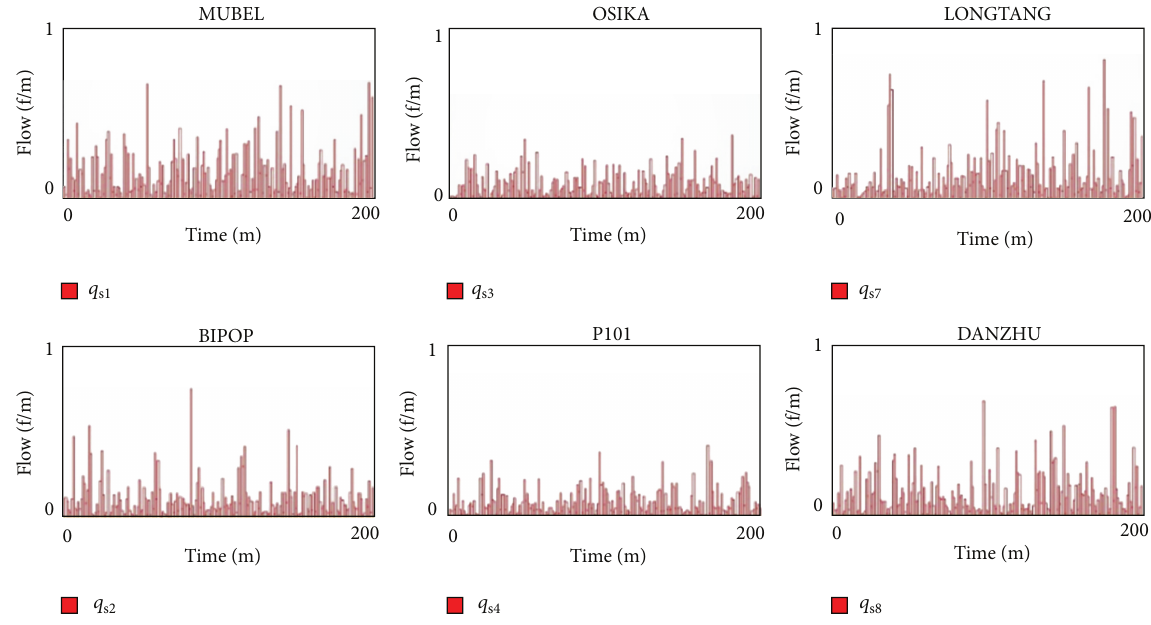
Figure 6: Changes of traffic flow over time at entry